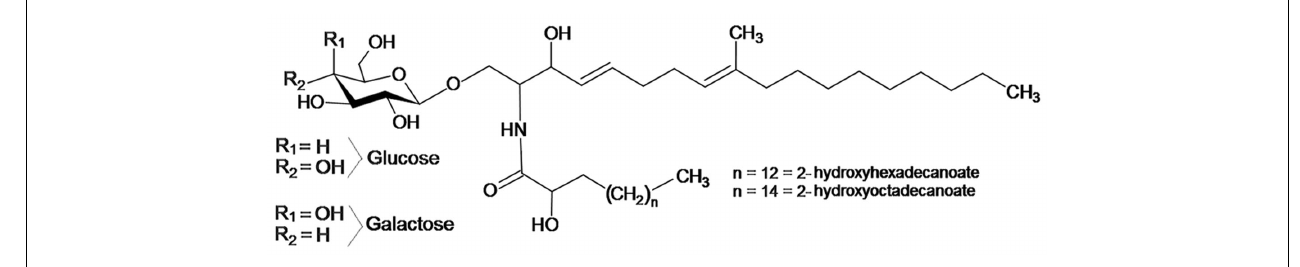
FIGURE 1 |Typical fungal cerebroside structure, containing a C19 sphingoid base with a C-9 methyl group, and two double bonds ( Δ 4, Δ